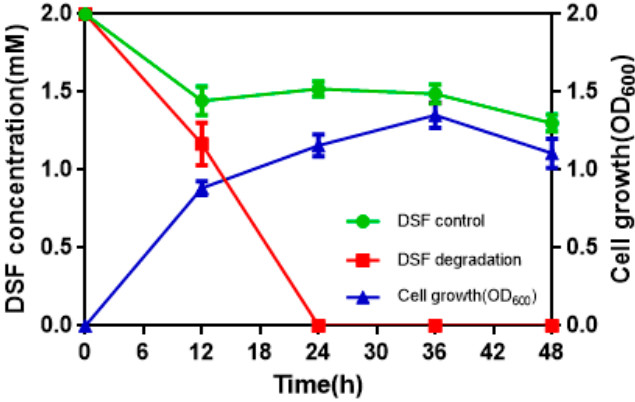
Figure 4. The relationship between diffusible signal factor (DSF) degradation and growth of strain HN-2. Values represent the mean of three trials. Each trial has three replicates. Bars indicate standard deviation of the mean.